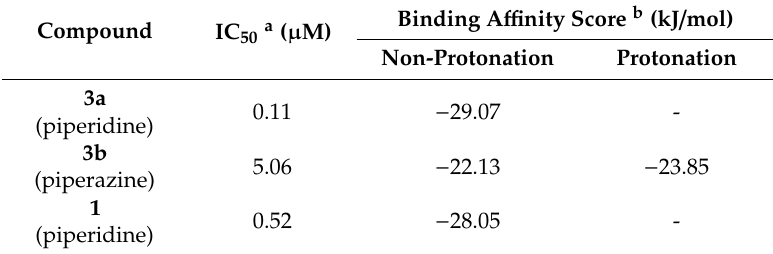
Figure 5. Stable conformers of 3a and 3b in the tunnel cavity of NAMPT. The conformational states of 3a ( a ) and 3b with its protonation form ( b ) in the tunnel cavity of NAMPT were analyzed by in silico binding mode analysis and crystal structure of 1 (PDB code: 2GVJ) [38–42]. The hydrogen interactions of axial-methylene with 1,3-diaxial hydrogens are represented by dashed lines. Table 1. Biochemical properties and binding affinity scores of 3a and 3b NAMPT inhibitors.